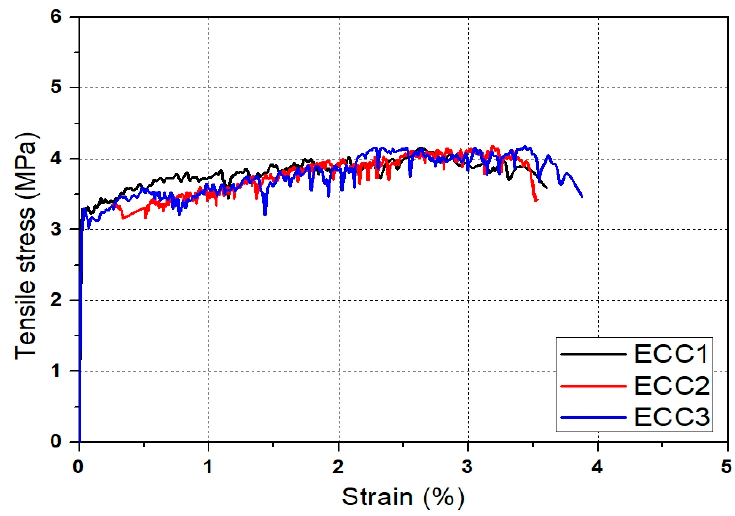
Figure 2. Tensile stress-strain curves of ECC. 2.2. Design and Manufacturing Process of Column Specimens Figure 3 shows the dimension and details of the specimens designed in this study. One specimen of the conventional RC column and two specimens of the RC composite columns (ECC 3 . 6 d to ECC 5 . 4 d ) were manufactured. The replacement length ( L R ) of concrete with ECC for each specimen is listed in Table 4. All specimens are composed of three parts: the head for applying the load, the main column, and the base. Eight D13 reinforcing bars were used